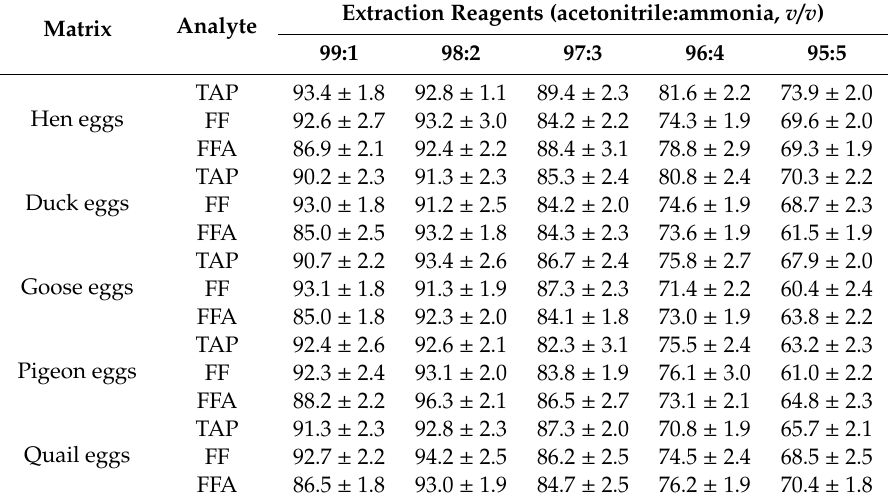
Table 1. E ff ects of di ff erent ratios of extraction reagents (acetonitrile:ammonia) for ASE on the recoveries of 25 µ g / kg TAP and 50 µ g / kg FF and FFA from poultry eggs (%) ( n =